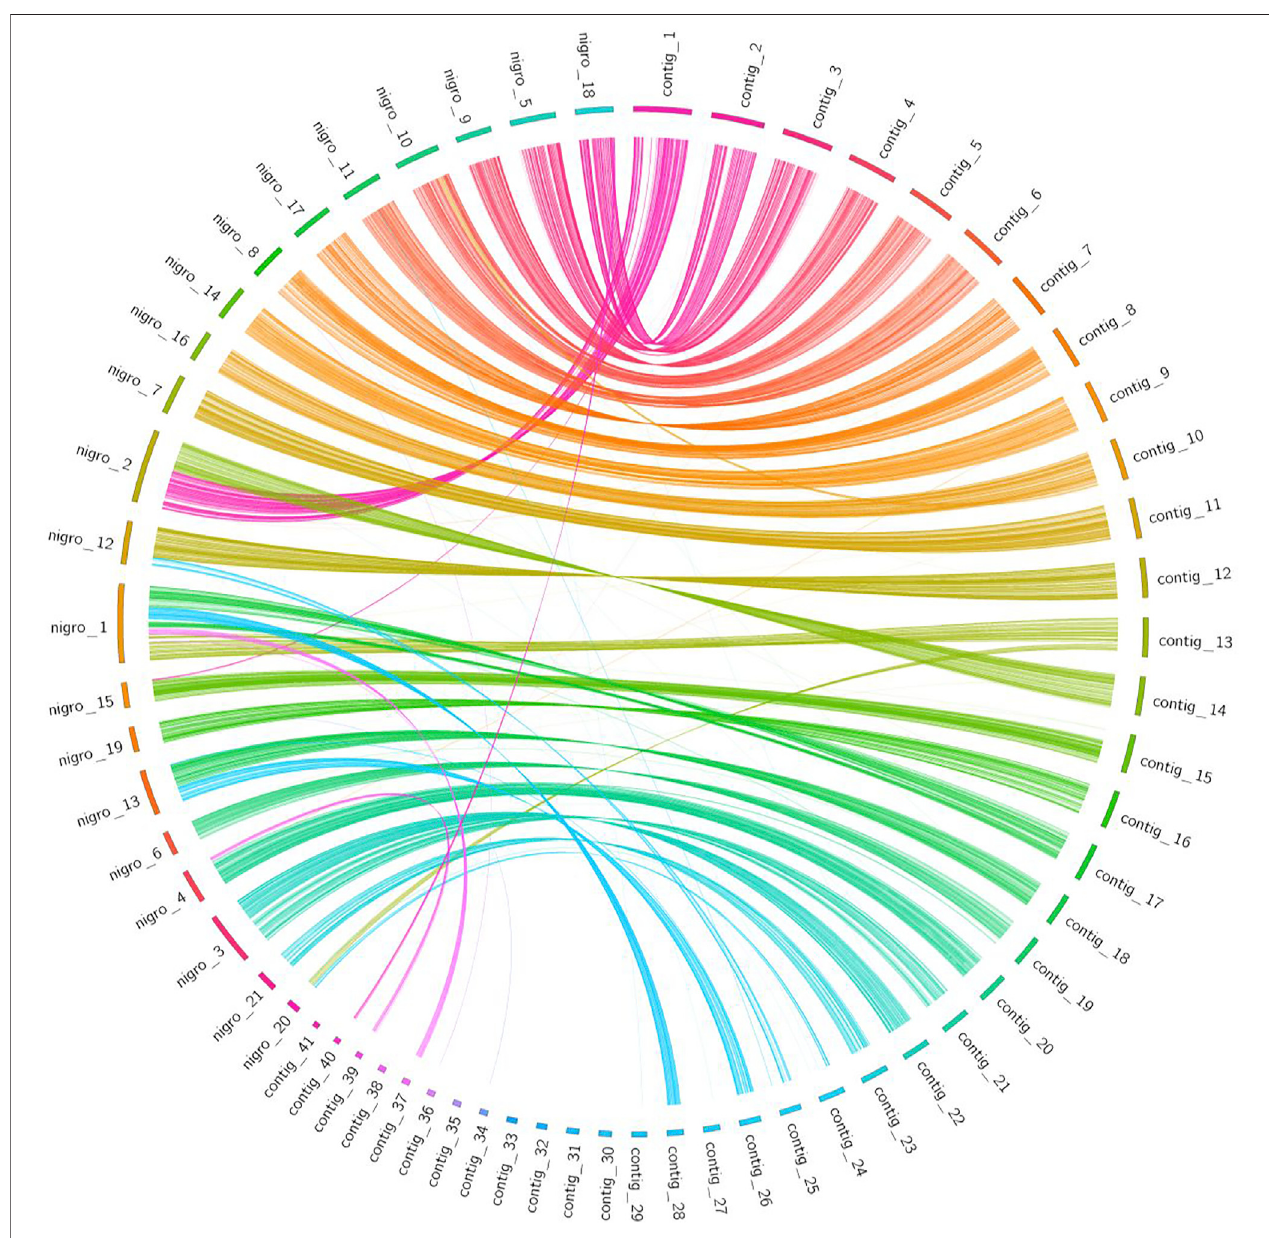
FIGURE 5 | Circos plot illustrating syntenic relationships between L. sceleratus contigs (right) against T. nigroviridis chromosomes (left), based on one-to-one orthologous genes. Ribbons link orthologous genes between the two species and colors represent the different contigs of L. sceleratus .